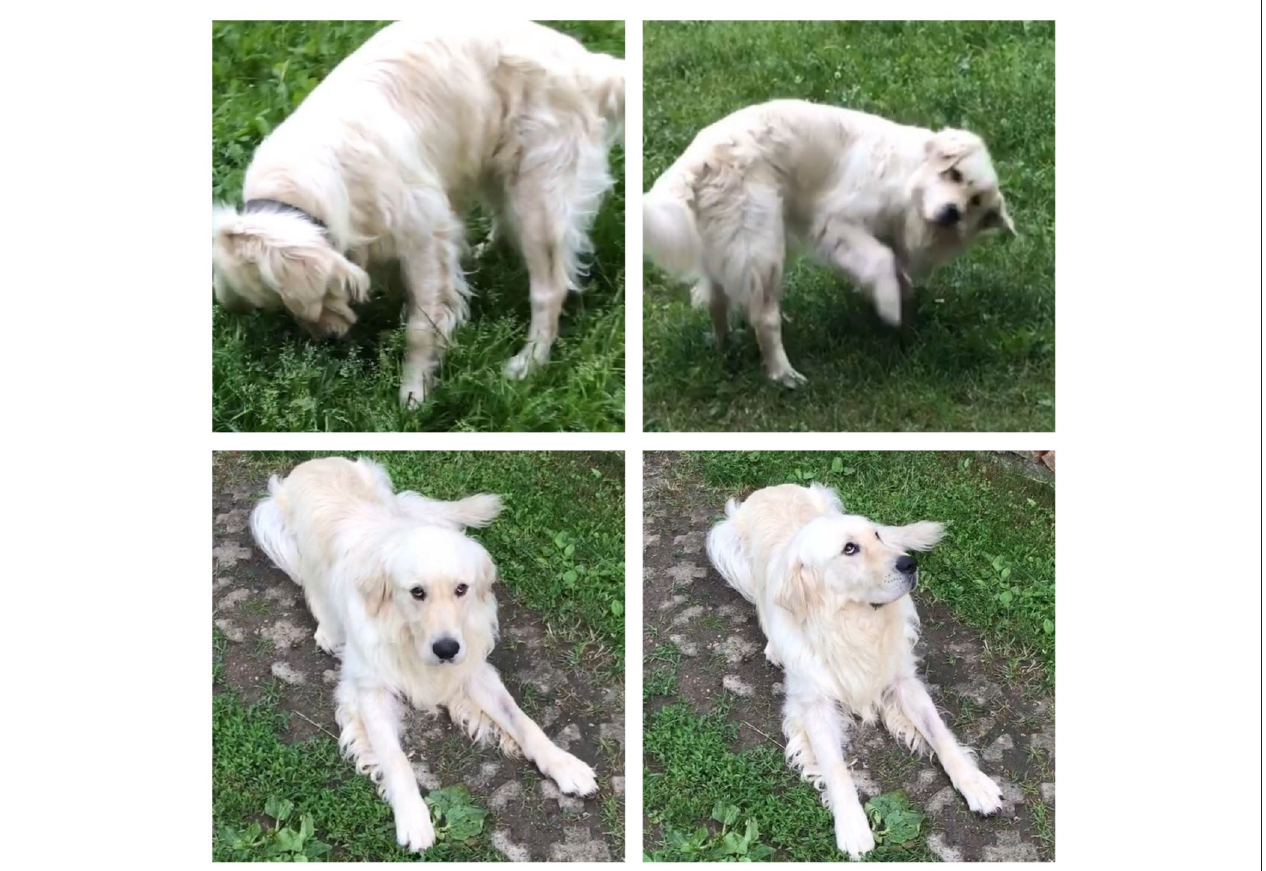
FIGURE 1 | Vestibular signs of the dog in case 1. The lower images show sternal position with vertical nystagmus and inability to stand up following the extension of the neck. The upper images focusing on the sniffing behavior with abnormal body and head position (upper left) leading to transient vestibular signs (upper